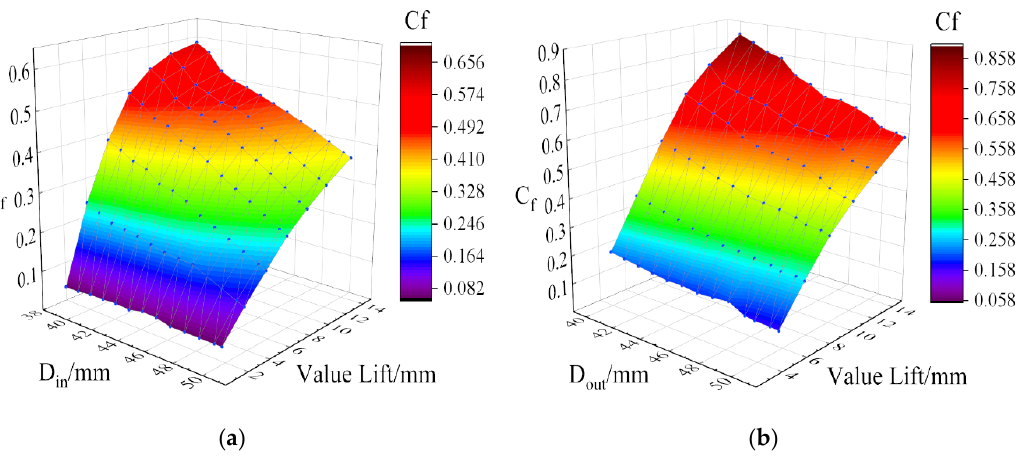
Figure 4. ( a ) Map diagram of intake throat diameter, valve lift, and flow coefficient; ( b ) map diagram of exhaust throat diameter, valve lift, and flow coefficient.